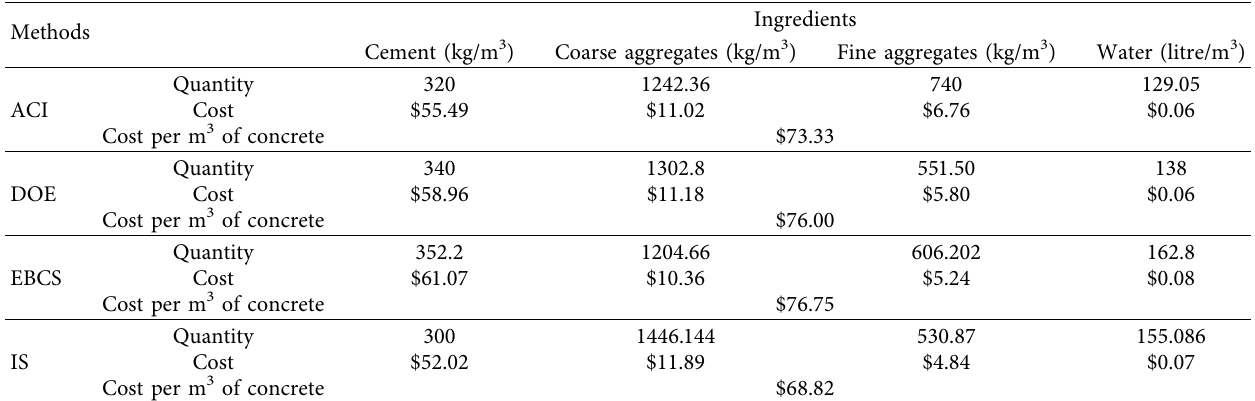
Table 7: Summary of cost analysis for different mix design methods.